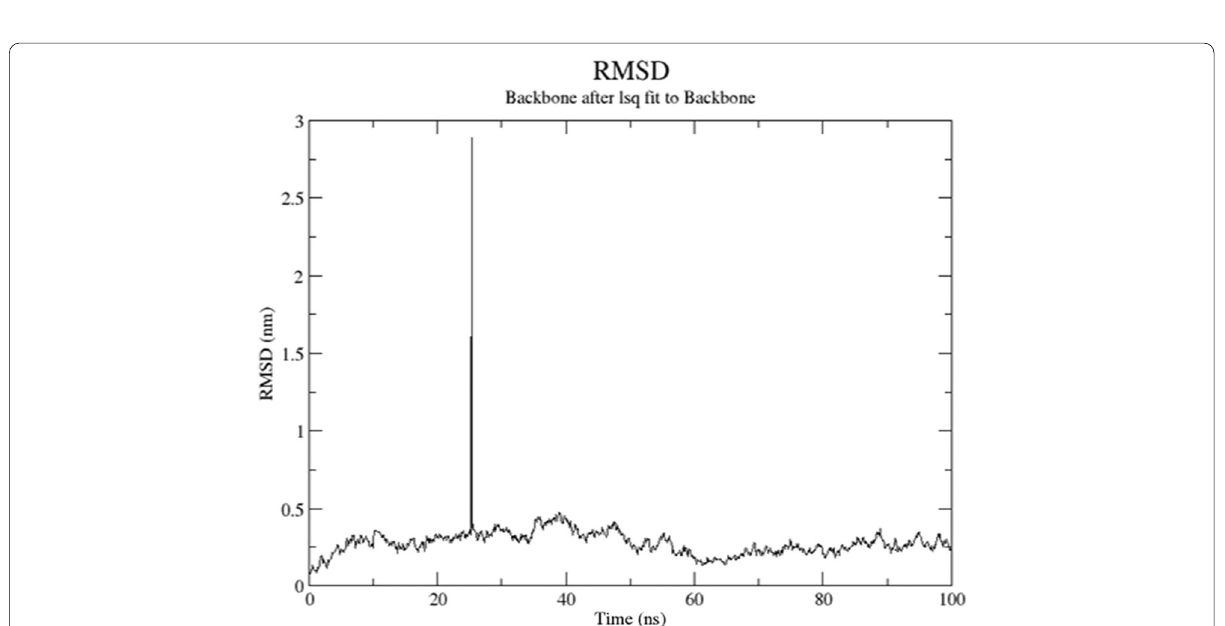
Fig. 7 RMSD values of the docked complex of HLA DR1 (PDB: 4AH2) and the designed construct during molecular simulation analysis at the 100‑ns time